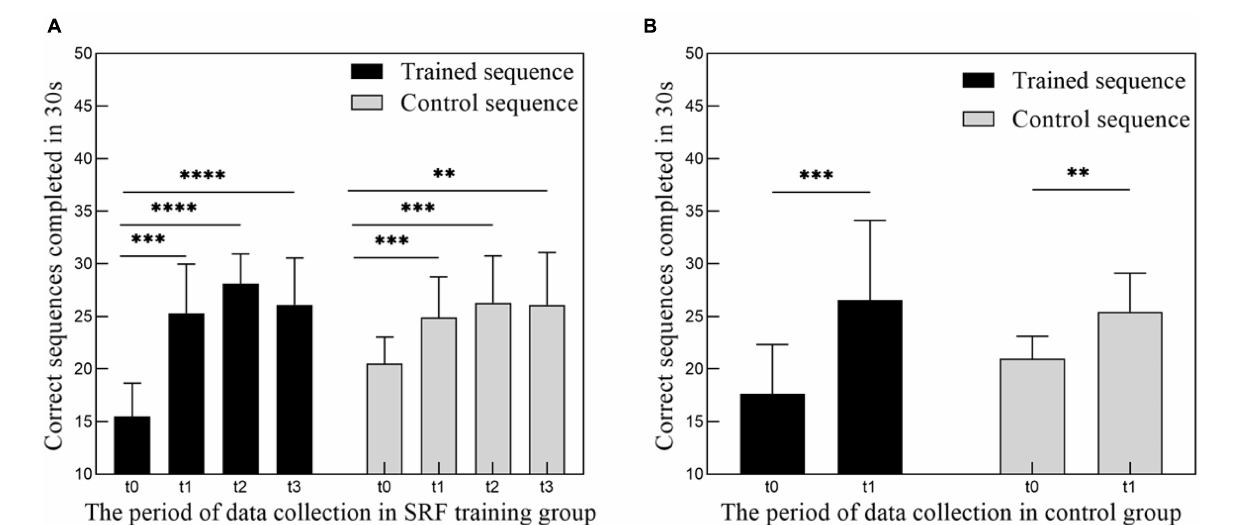
FIGURE 2 | (A) Increase in performance of motor training tasks following 4 weeks of SRF training. Group data ( n = 10) showing number of correct sequences (trained and control sequence) performed in 4 periods (t0, t1, t2, t3) of data collection. (B) Increase in performance of motor training tasks following 2 weeks of finger movement training. Group data ( n = 9) showing number of correct sequences (trained and control sequence) performed in 2 periods (t0, t1) of data collection. Data represent mean ± SEM, ∗ indicates a significant difference in the two groups. ∗∗ p < 0.01, ∗∗∗ p < 0.005, ∗∗∗∗ p <